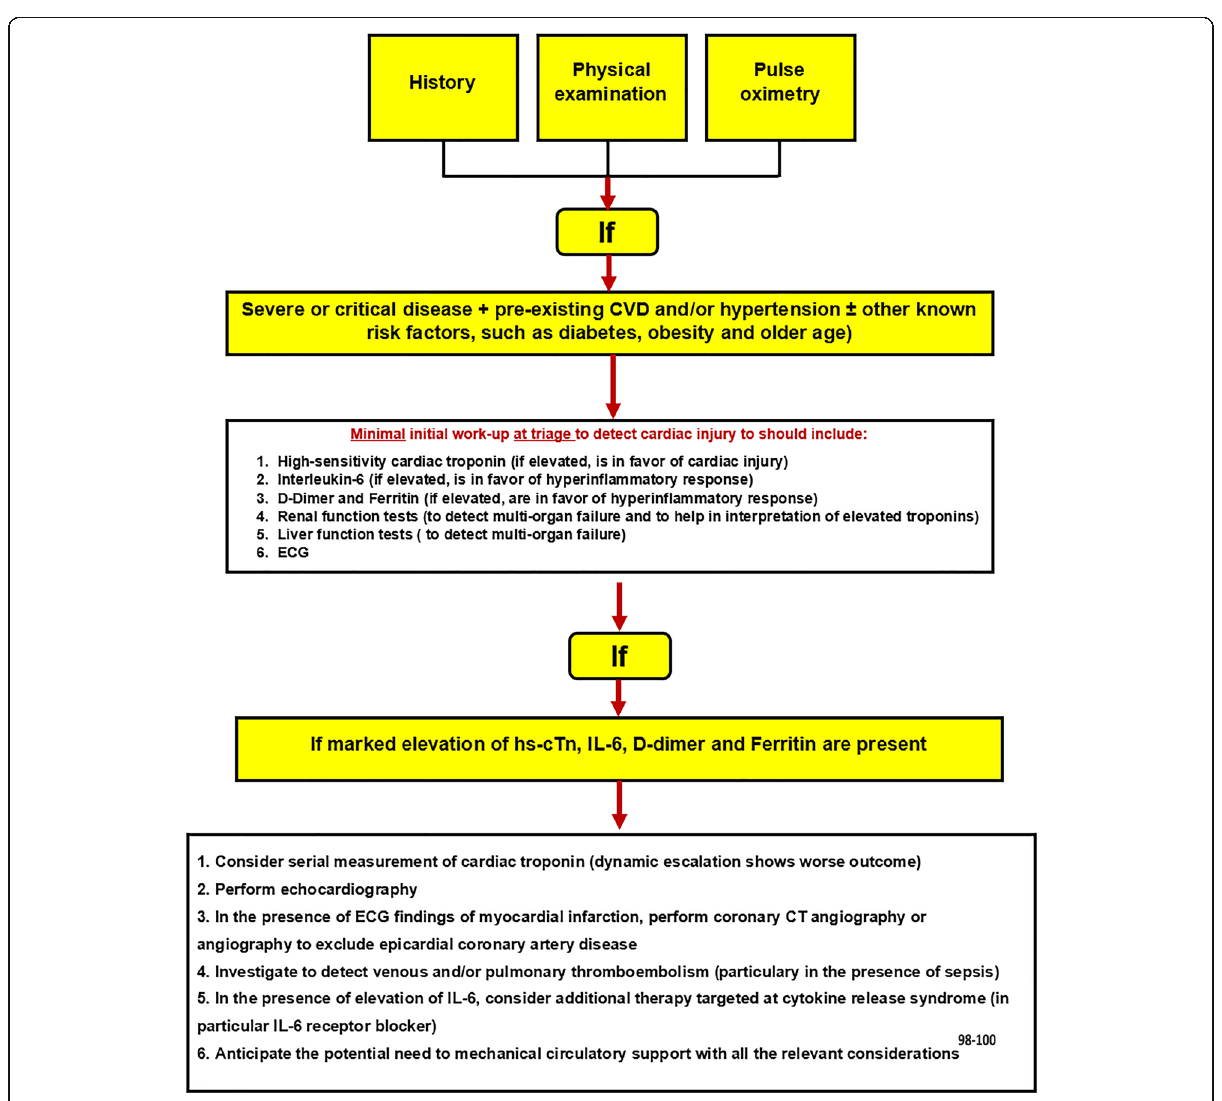
Fig. 8 Triage risk stratification tool for high-risk patients with COVID-19 and cardiovascular